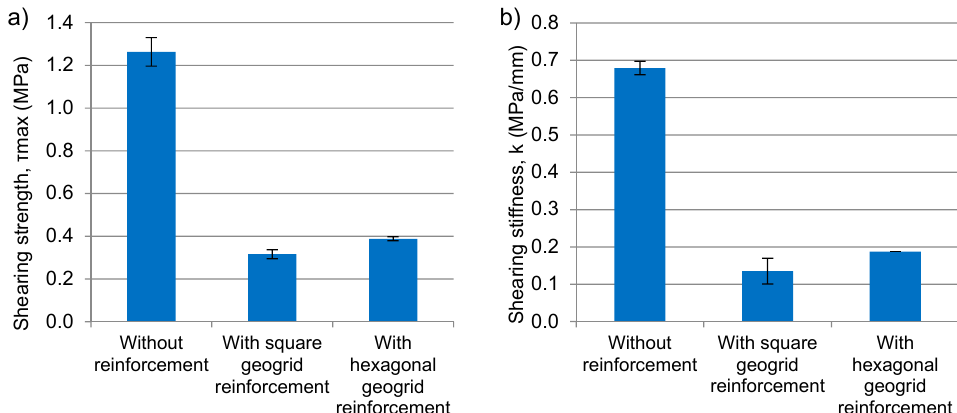
Figure 7. Shearing strength ( a ) and shearing stiffness ( b ) of systems without reinforcement, with hexagonal geogrid and with square aperture geogrid reinforcement.